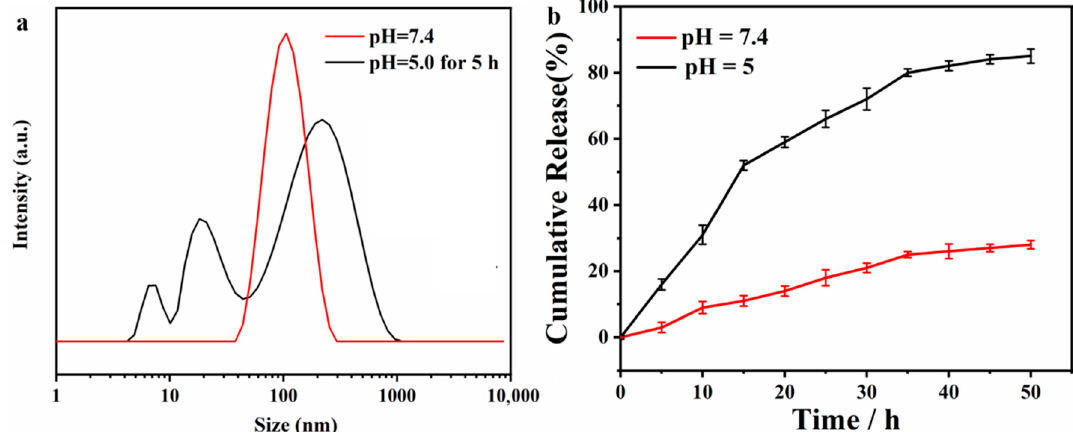
Figure 3. The characterization of micelles and in vitro release of PU-hyd-DOX: ( a ) the particle size of micelles in different conditions; ( b ) the drug release of PU-hyd-DOX in vitro.